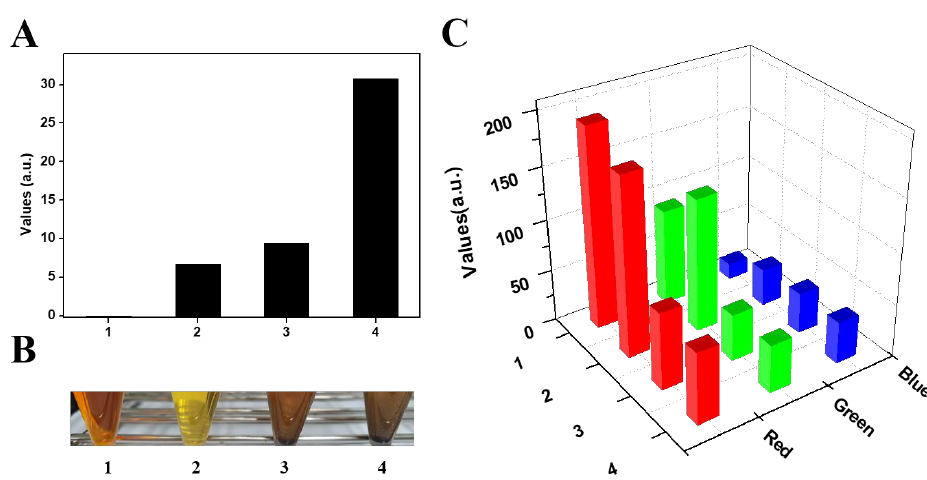
Figure 6. ( A ) Spectral responses for the detection of hydrazine decomposition in the presence of H 2 O 2 (0.2 M) and different concentrations of Fe 2+ (2 and 32 ppm respectively); ( B ) color changes for different concentrations of Fe 2 + (2 and 32 ppm respectively); ( C ) RGB profiles for di ff erent concentrations of Fe 2+ (2 and 32 ppm respectively). 1 represents the control without H 2 O 2 and 2, 3, and 4 represent with H 2 O 2, with H 2 O 2 and Fe 2+ (2 ppm), and with H 2 O 2 and Fe 2+ (32 ppm). The concentration of p-dimethylaminobenzaldehyde used was 4 × 10 − 6 M.